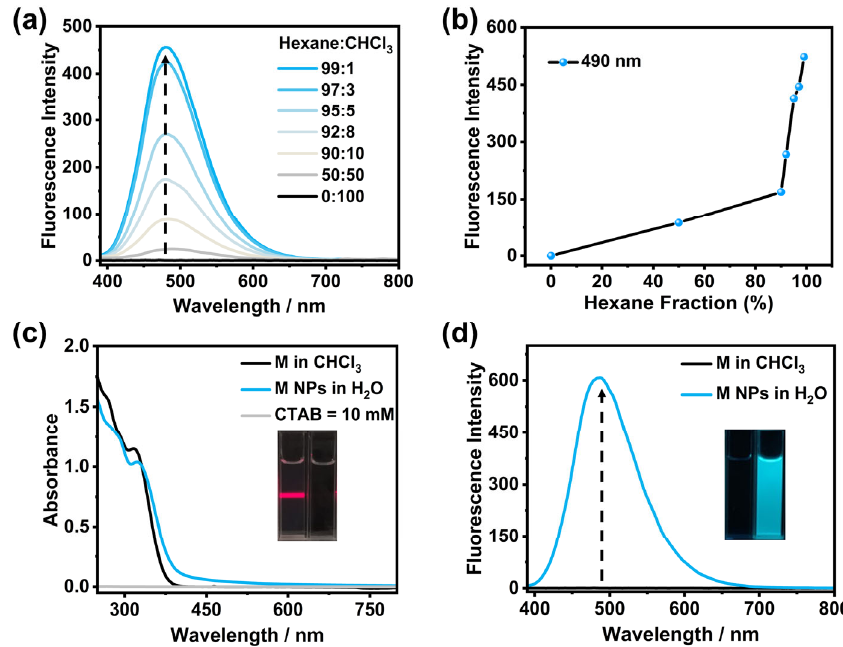
Figure 1. ( a ) Fluorescence spectra of M in mixed hexane/CHCl 3 solvents at different vol% upon excitation at 330 nm. ( b ) Fluorescence intensity of M at 490 nm in the presence of different factions of hexane in mixed solution. ( c ) UV ‐ Vis spectra of M in CHCl 3 and the prepared M NPs in water, inset: Tyndall effect of M NPs in water (left) and M in CHCl 3 (right). ( d ) Fluorescence spectra of M in CHCl 3 and in water, inset: fluorescence images of M in pure CHCl 3 (left) and water (right). [ M ] = 5 × 10 − 5 M.